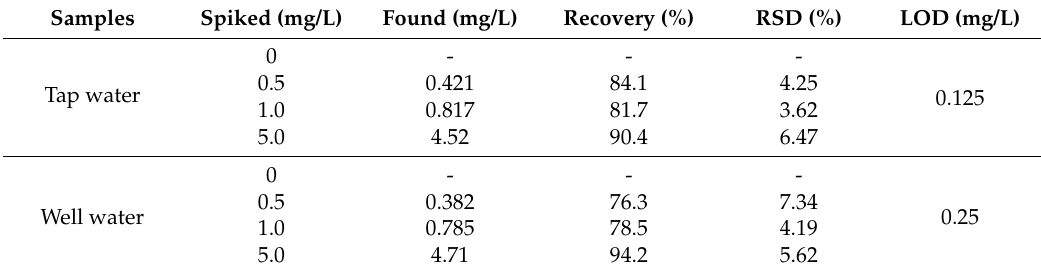
Table 2. Recoveries of chlorsulfuron in water samples ( n = 3). RSD: Relative Standard Deviations. Samples Spiked (mg/L) Found (mg/L) Recovery (%) RSD (%) LOD (mg/L) 0 Tap water